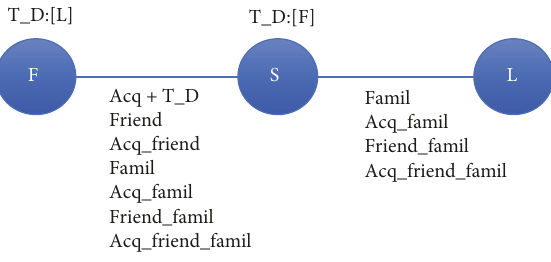
Figure 10: Two-step resource sharing in normal